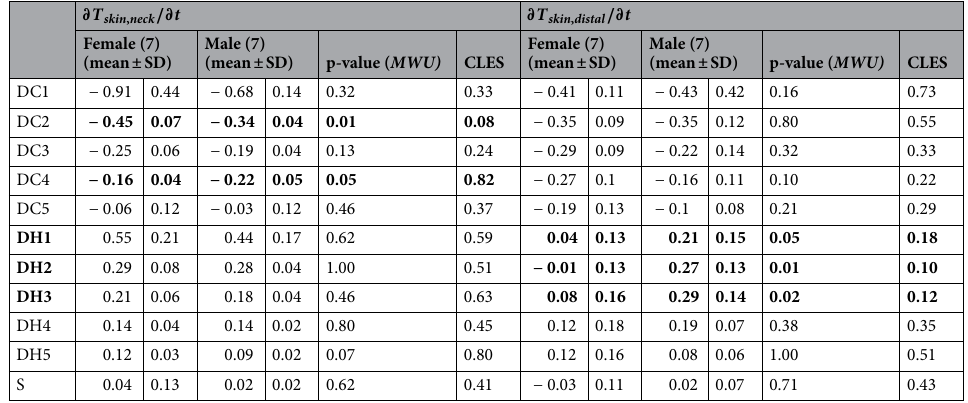
Table 8. Sex differences in the rate of change of the neck and distal skin temperature over the course of the last two partial-body cooling and warming transients. Significant values are in bold.